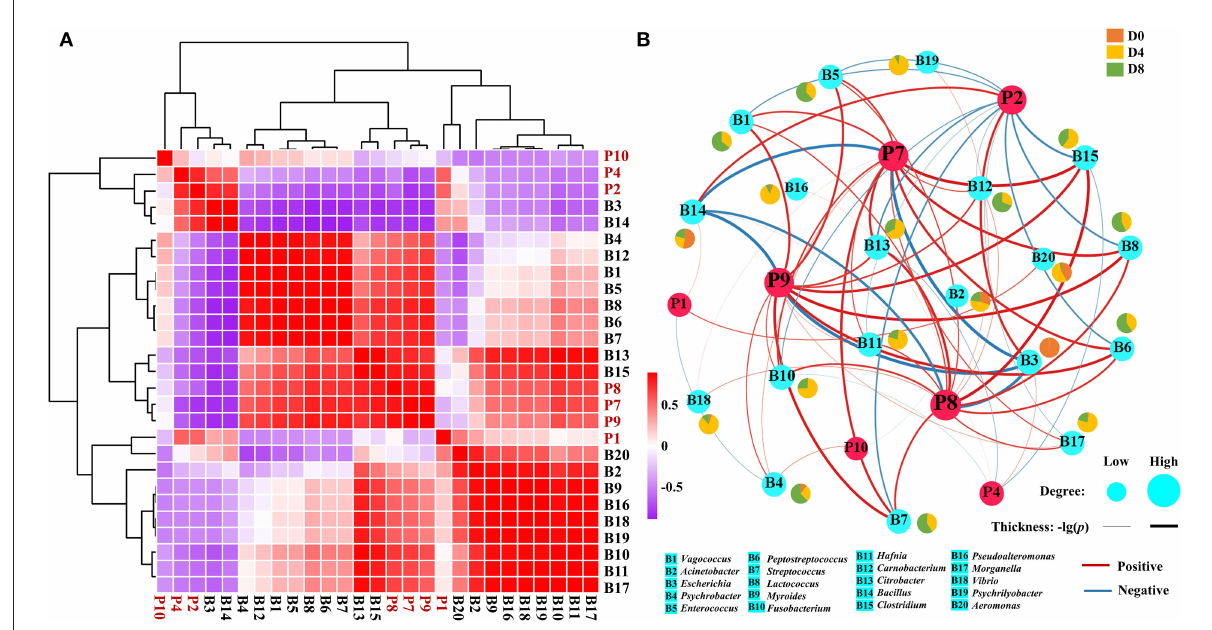
FIGURE5 Correlation analysis between the ACE inhibitory peptides and microbial genera. (A) Clustering heatmap and (B) correlation network (| r | > 0.6 and p < 0.05) based on Pearson’s correlation